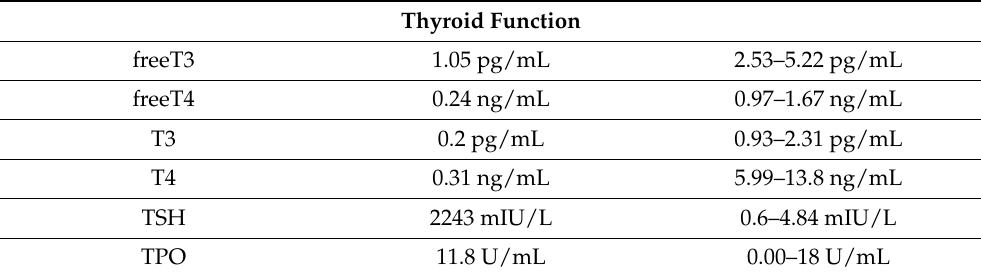
Table 4. Thyroid laboratory parameters on